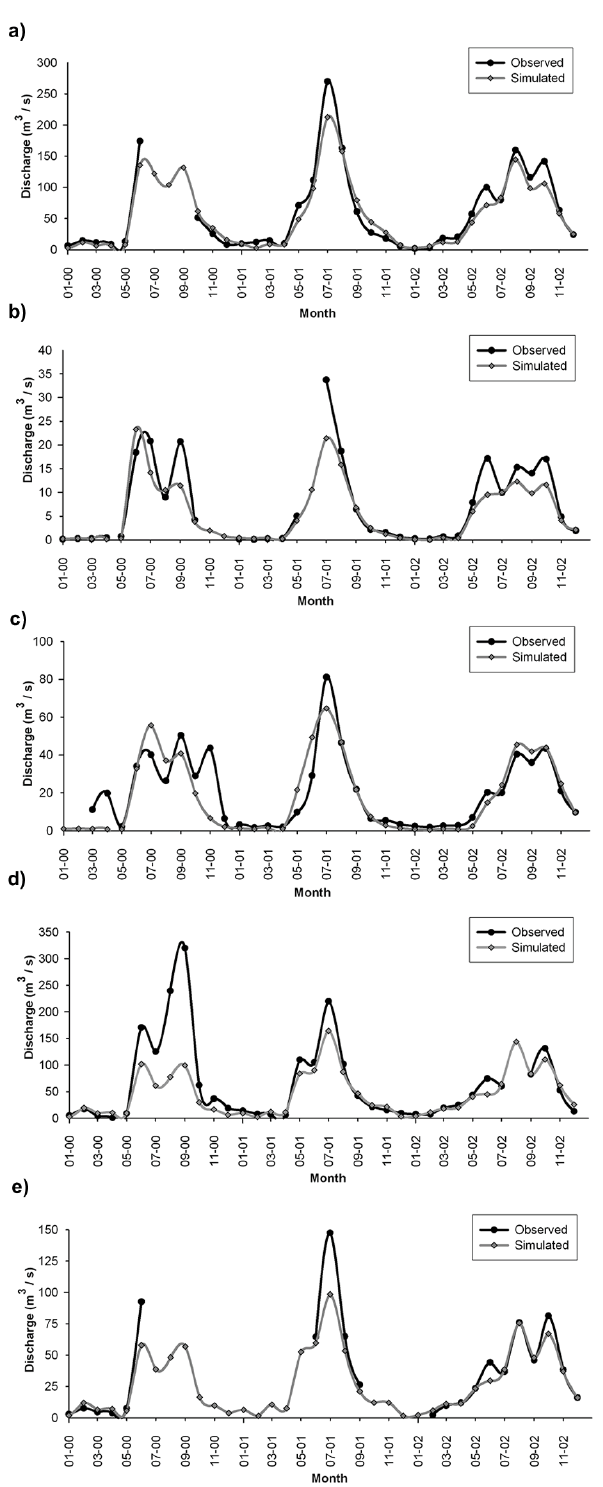
Fig. 8. Observed and simulated mean monthly discharges during years 2000–2002 at Tijeral (a) , Rehue (b) , Mininco (c) , Renaico (d) and Malleco (e) .